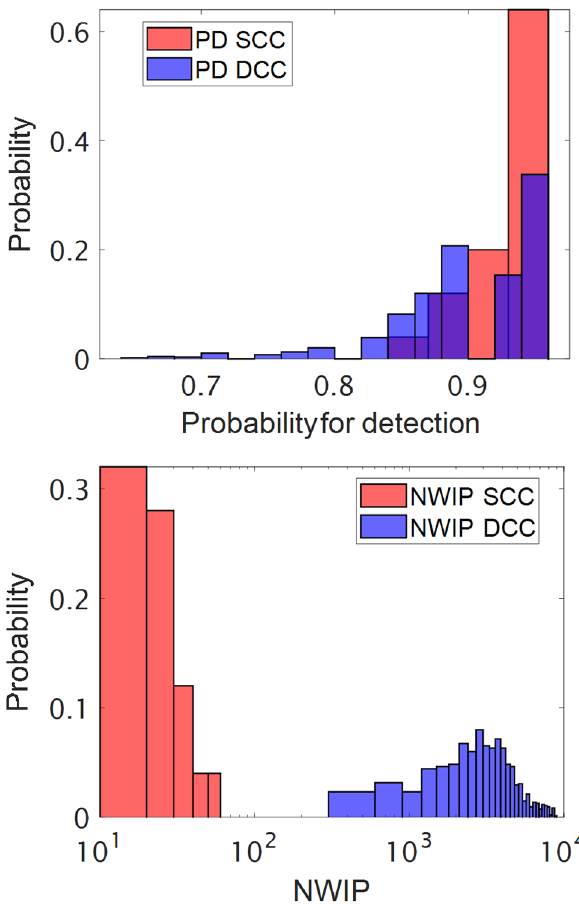
Figure 5. Top: target detection rate distribution using the DCC and DCC approach in conventional ML. Bottom: the same for NWIP using a logarithmic scale.